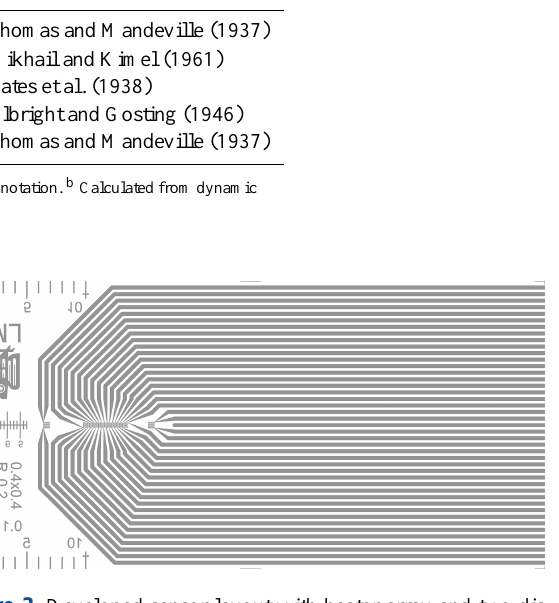
Figure 3. Developed sensor layout with heater array and two dis- tinct temperature sensors. The chips are contacted using FPC con- nectors (Schmitt et al., 2013b).